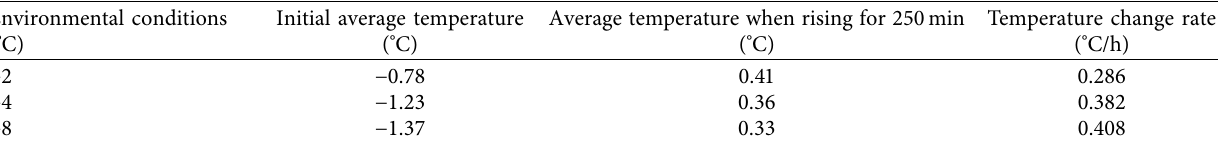
Figure 13: Temperature change curves of measuring points Nos. 7, 8, and 9 under various working conditions of ice melting experiment: (a) − 2 ° C; (b) − 4 ° C; (c) − 8 ° C. Table 8: Temperature change rate of the first layer’s measurement points Nos. 7, 8, and 9 of the ice melting experiment. Environmental